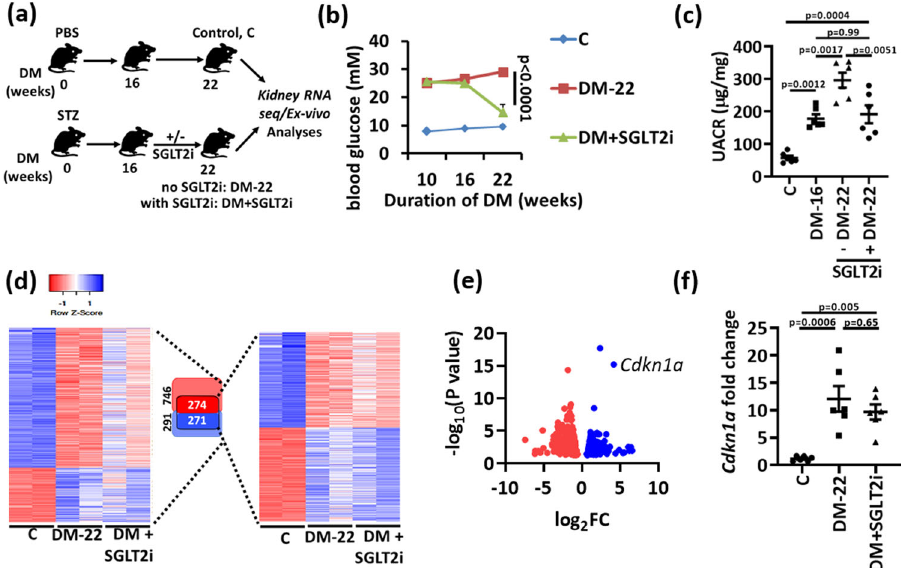
Fig. 1 | Identi fi cation of genes and pathways associated with hyperglycemic memory. a Experimental scheme showing non-diabetic control (C) or diabetic mice without (DM-22) or with intervention to reduce blood glucose levels by sodium/glucose cotransporter-2 inhibitor (Dapagli fl ozin ® , DM+SGLT2i).